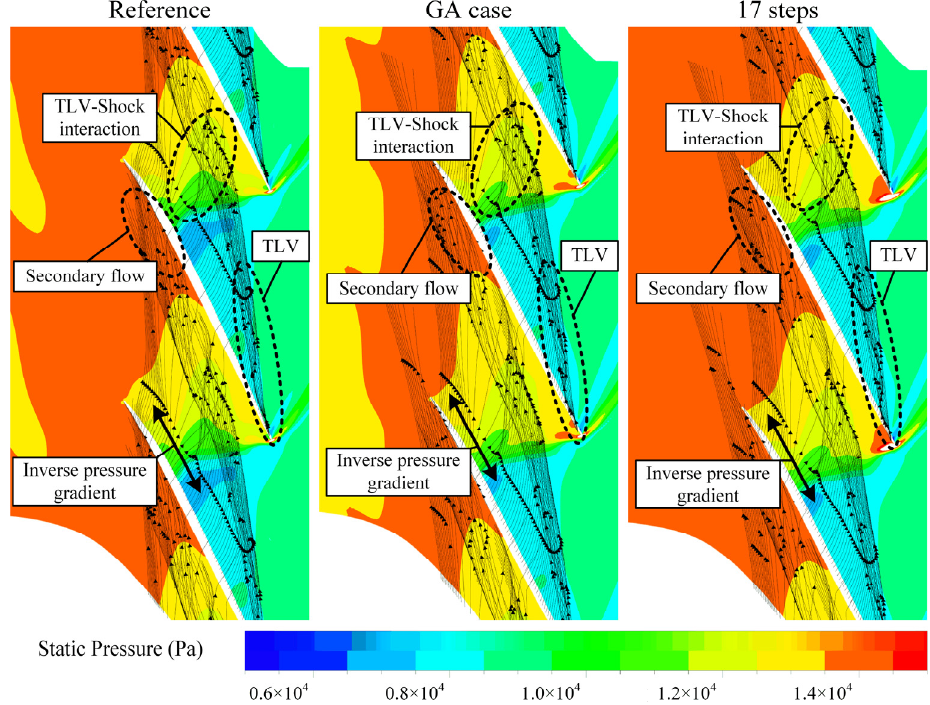
Figure 22. Tip leakage flow of the rotors and static pressure distribution at 99.8% spanwise.